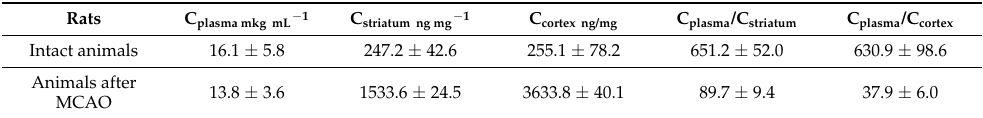
Table 6. The plasma concentration ratio of compound 1 in the striatum and cerebral cortex in intact animals and rats 24 h after